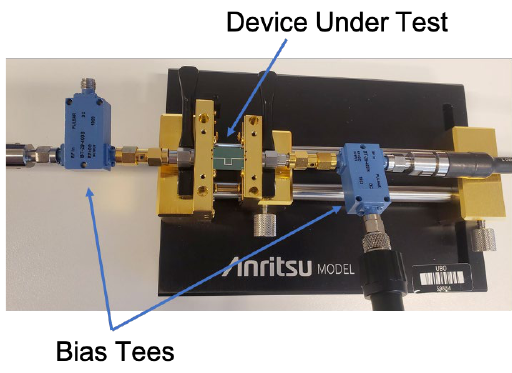
Figure 17. Photograph of the 10 GHz filter under test.